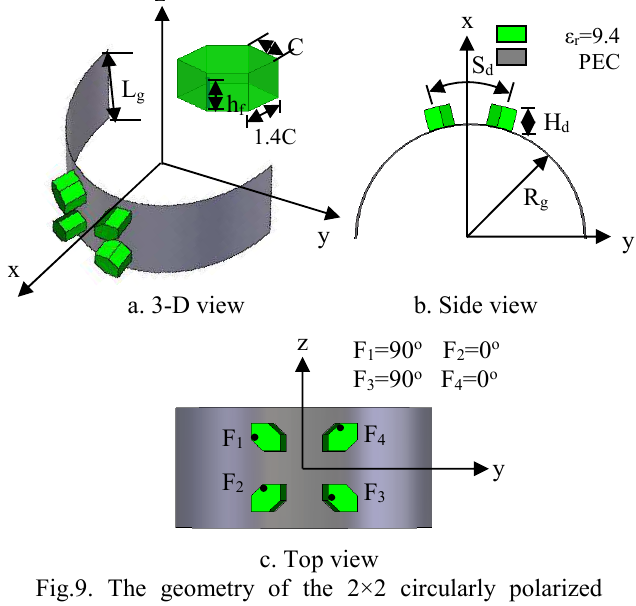
Fig.9. The geometry of the 2×2 circularly polarized DRA array elements mounted on a cylindrical ground plane in free